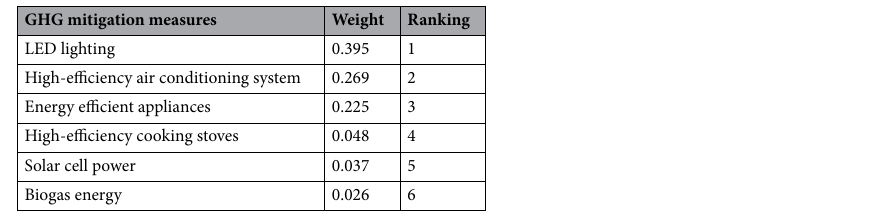
Table 3. Overall AHP-weighting of GHG mitigation measures (CR = 0.0542).